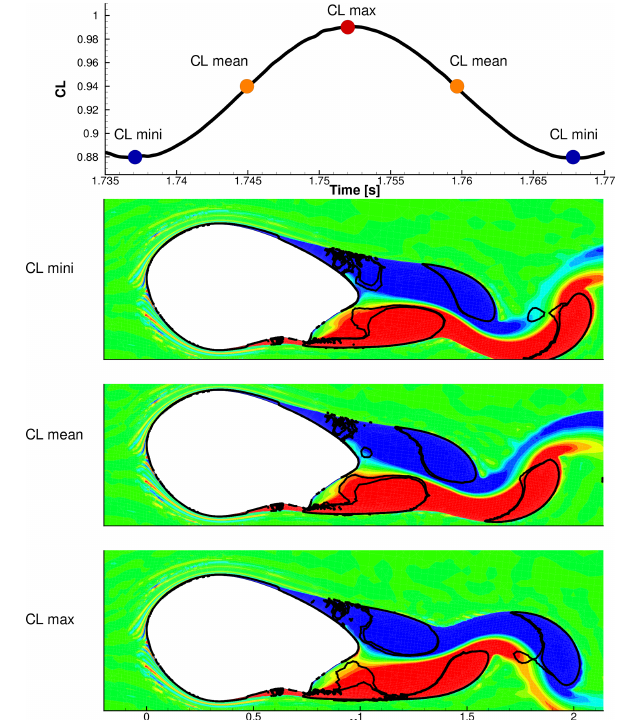
Figure 11. Spoiler case illustration of vortices in the vicinity of the trailing edge in relation with the lift coefficient evolution for α = 6 ◦ and Re c = 3 × 10 6 . The contour plots depict instantaneous vorticity contour with Q-criteria lines.